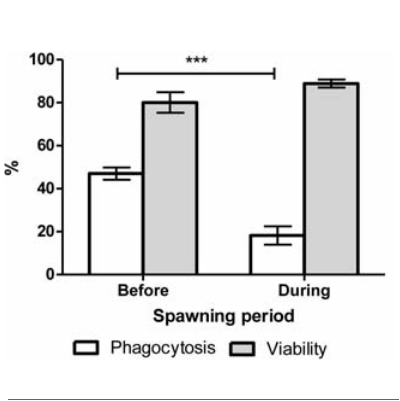
***P<0.0001.Figure 1. Analysis of (A) lipid peroxidation (LPO), (B) vitellogenin-like proteins and (C) in gonads of mussels before and during spawning period. No significant differences are observed. COX,